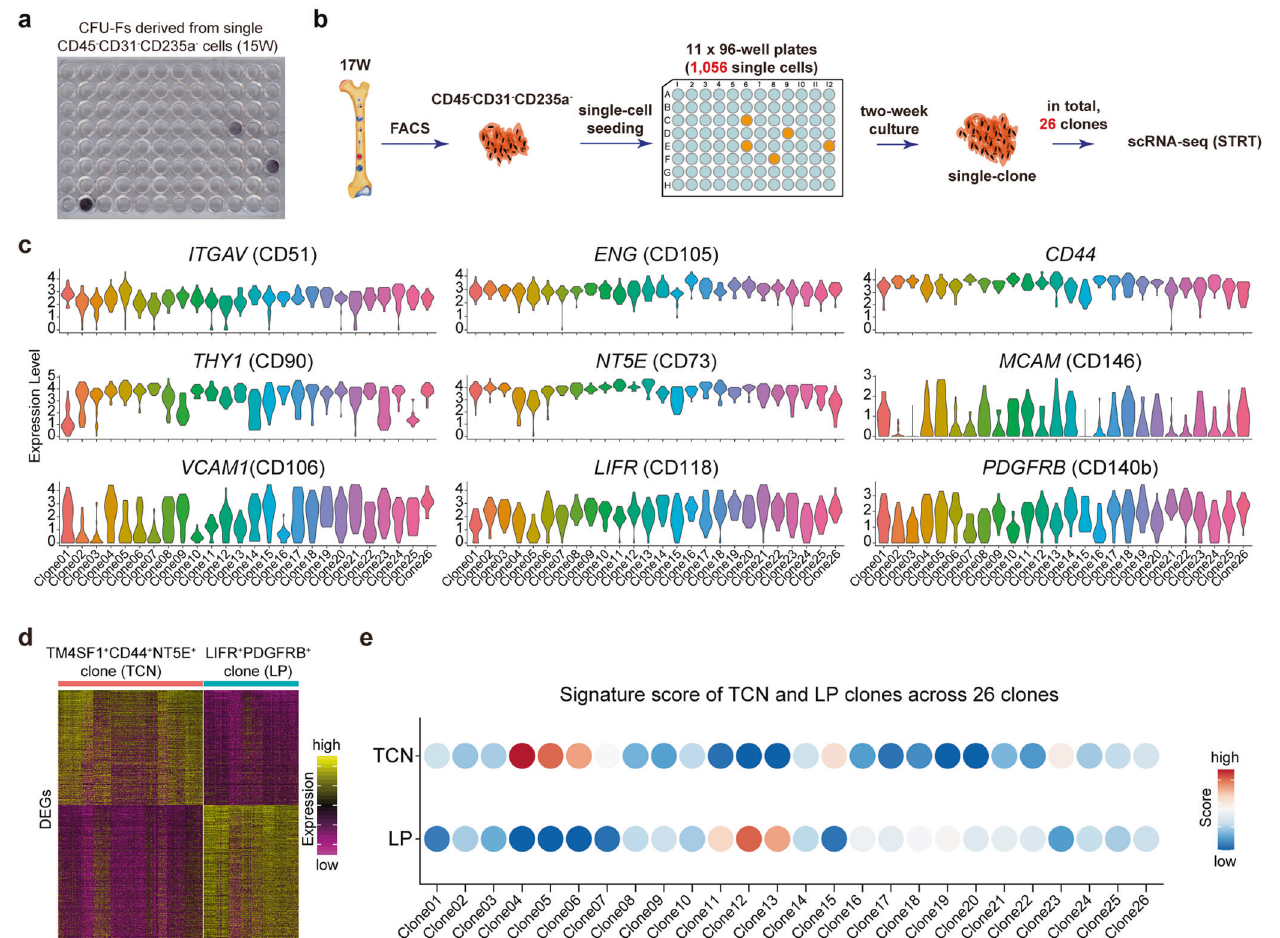
Fig. 5 CFU-F activity of human fetal BM mesenchymal cells. a CFU-Fs from human fetal BM CD45 - CD31 - CD235a - cells. b Study overview of the CFU-F assay of human fetal BM CD45 - CD31 - CD235a - cells. c Violin plots showing the expression levels of representative surface marker genes in all single clones derived from single CD45 - CD31 - CD235a - cells. d Heatmap showing the DEGs between TCN clones and LP clones. The color key from purple to yellow indicates low to high expression levels, respectively. e Signature score of TCN and LP clones across all 26 clones derived from single CD45 - CD31 - CD235a -